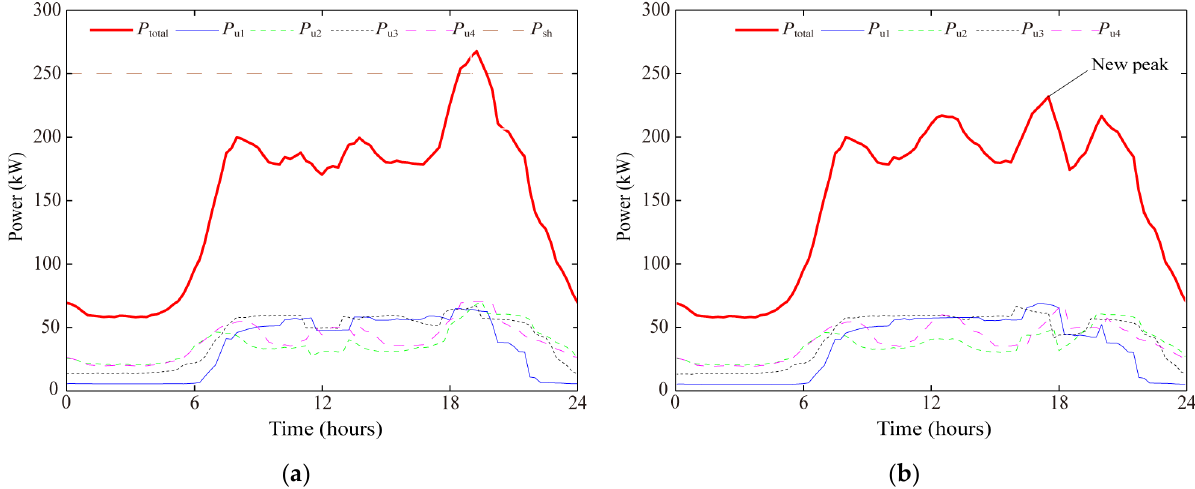
Figure 3. ( a ) Actual power consumption profiles with exceeding the threshold of the power grid; ( b ) Actual power consumption profiles with new peak of the power grid.